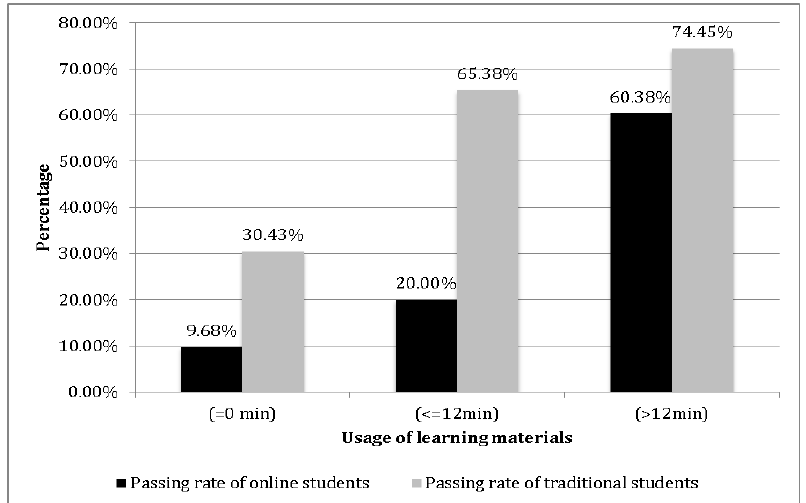
Figure 4 . Comparison of percentage of students who passed the course within each group.